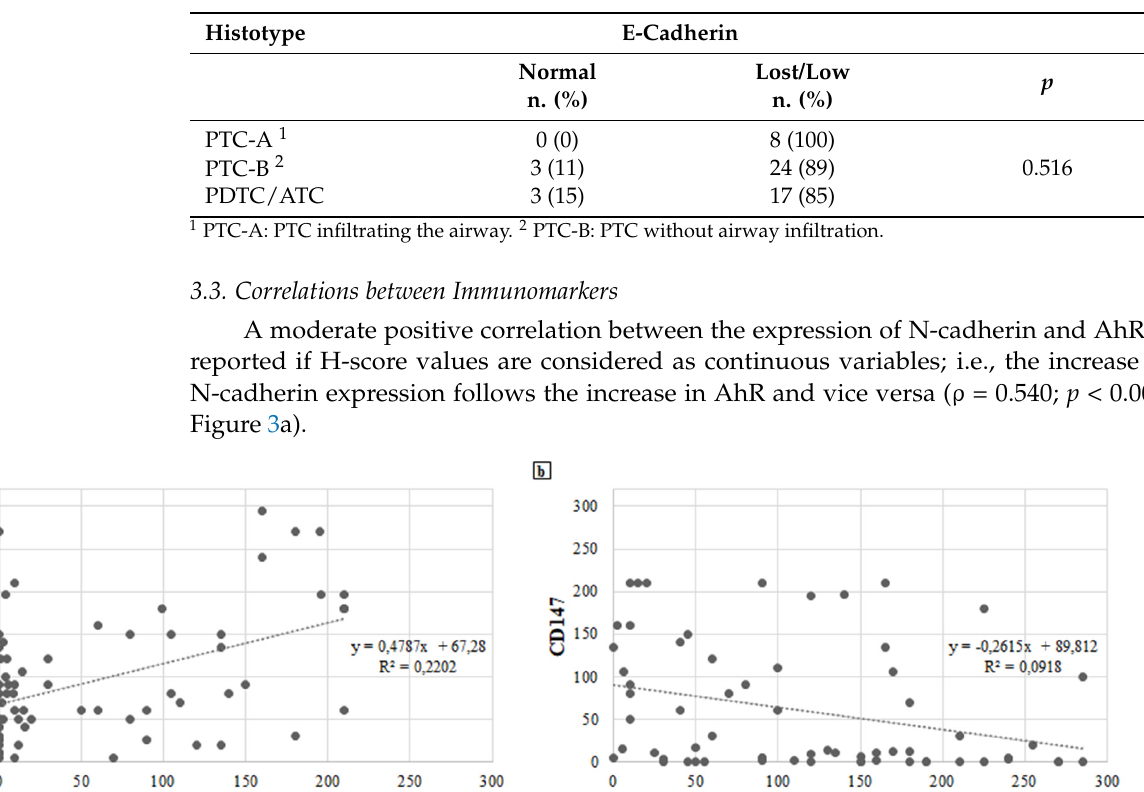
Table 4. E-cadherin distribution among tumour groups.